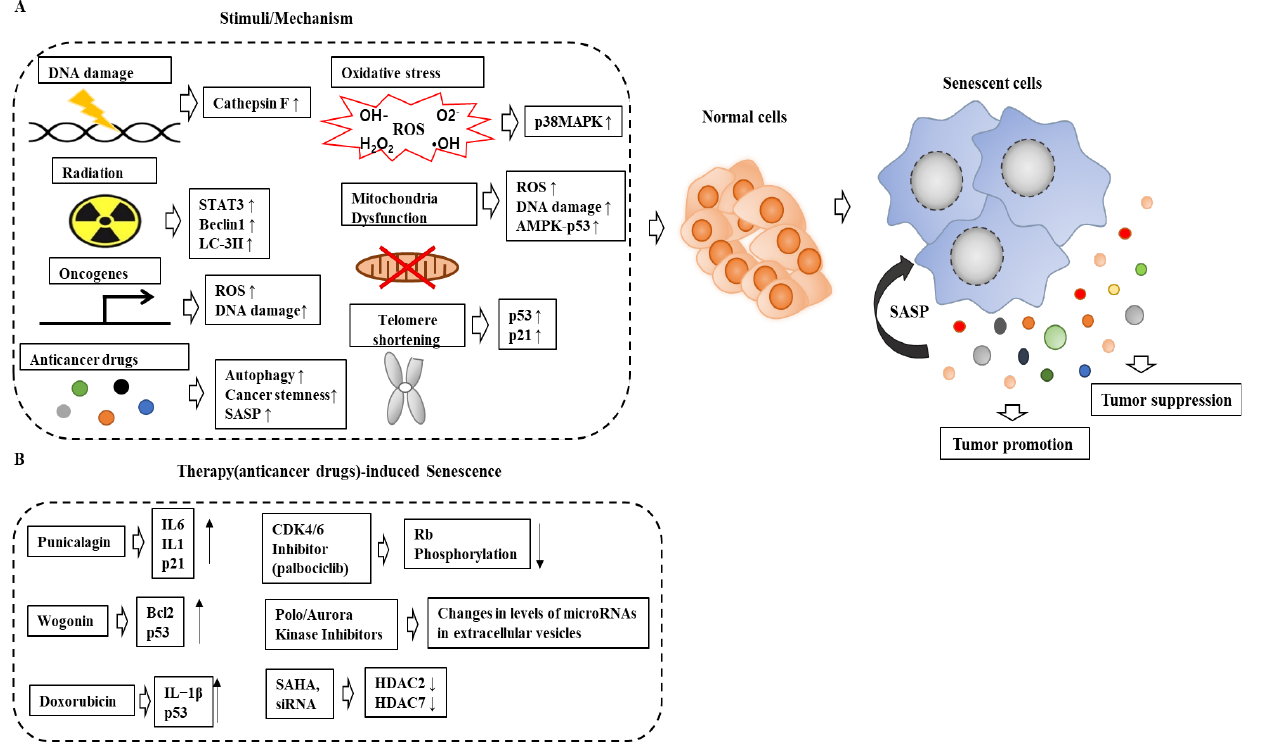
Figure 2. Factors inducing senescence and the mechanisms of senescence are shown. ( A ) Various factors induce senescence. Senescence initially leads to tumor suppression. Senescent cells can also promote tumor progression by recruiting immune suppressor cells, such as Treg cells and myeloid-derived suppressor cells (MDSCs). SAHA, an inhibitor of HDACs, is suberohydroxamic acid. ↑ indicates an increase in expression/activity. ↓ indicates a decrease in expression/activity. The hollow arrows indicate the direction of the reaction. ( B ) The mechanisms of therapy-induced senescence are also shown.